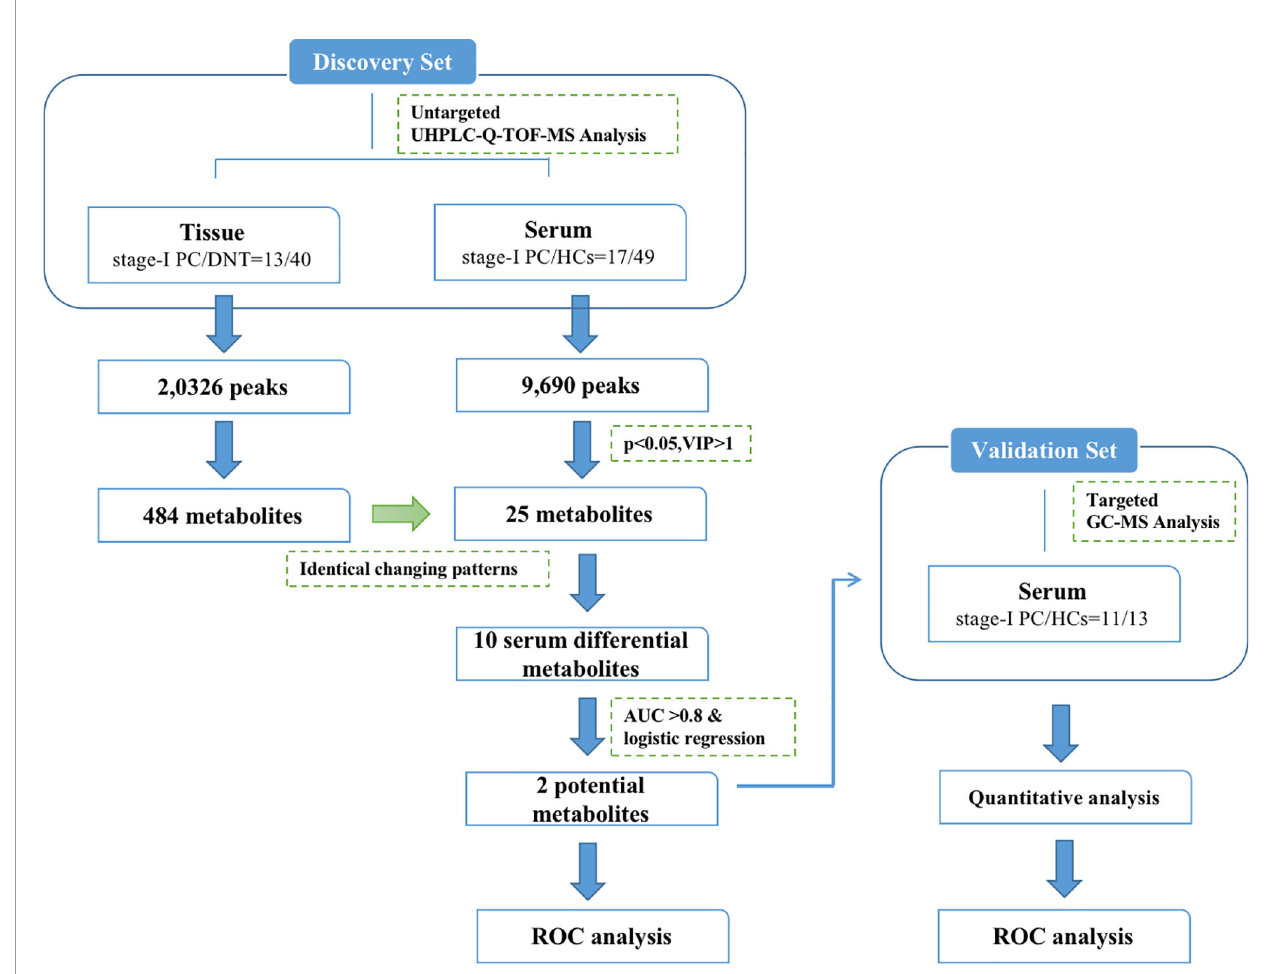
FIGURE 1 | The work fl ow for the study design and analytical